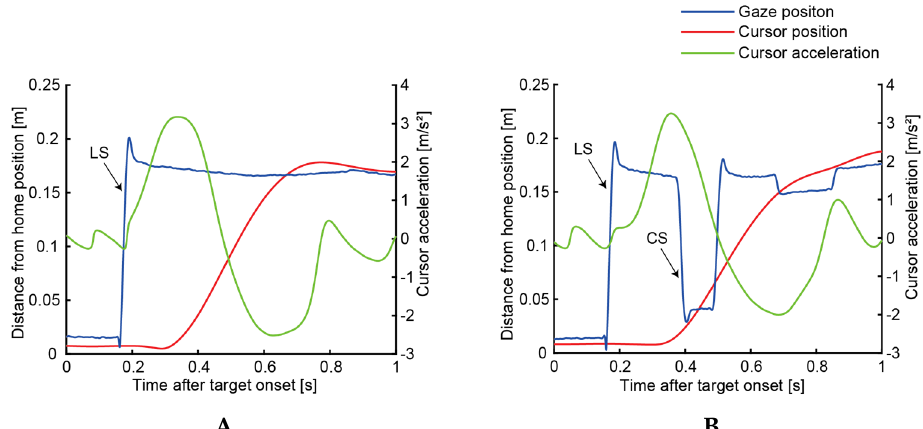
Figure 2. Two types of saccades during the hitting task are depicted. ( A ) leading saccade (LS) occurs almost simultaneously at the onset of acceleration of the cursor. ( B ) catching saccade (CS) follows LS in this trial.